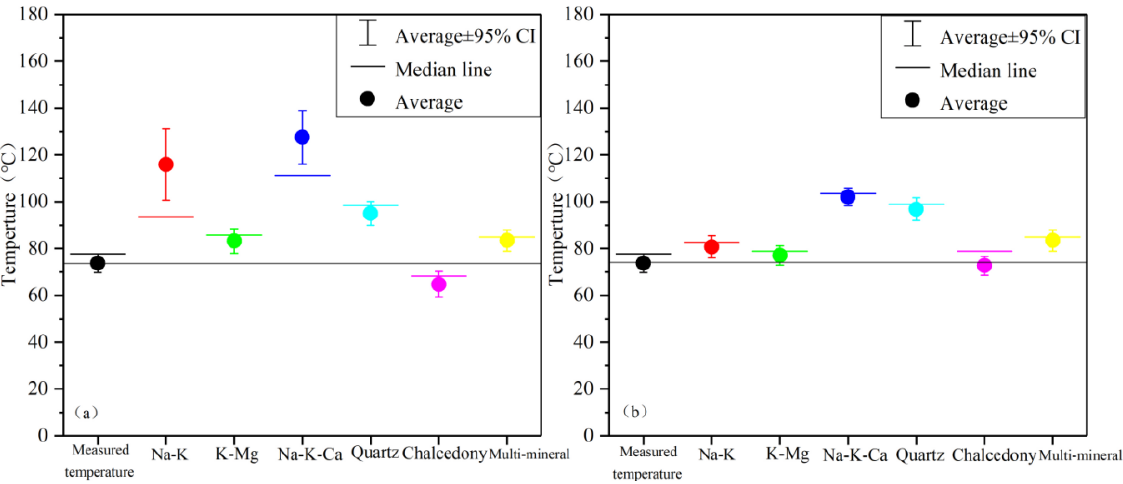
Figure 8. Comparison of direct use ( a ) and selective use ( b ) of geothermometer box types.